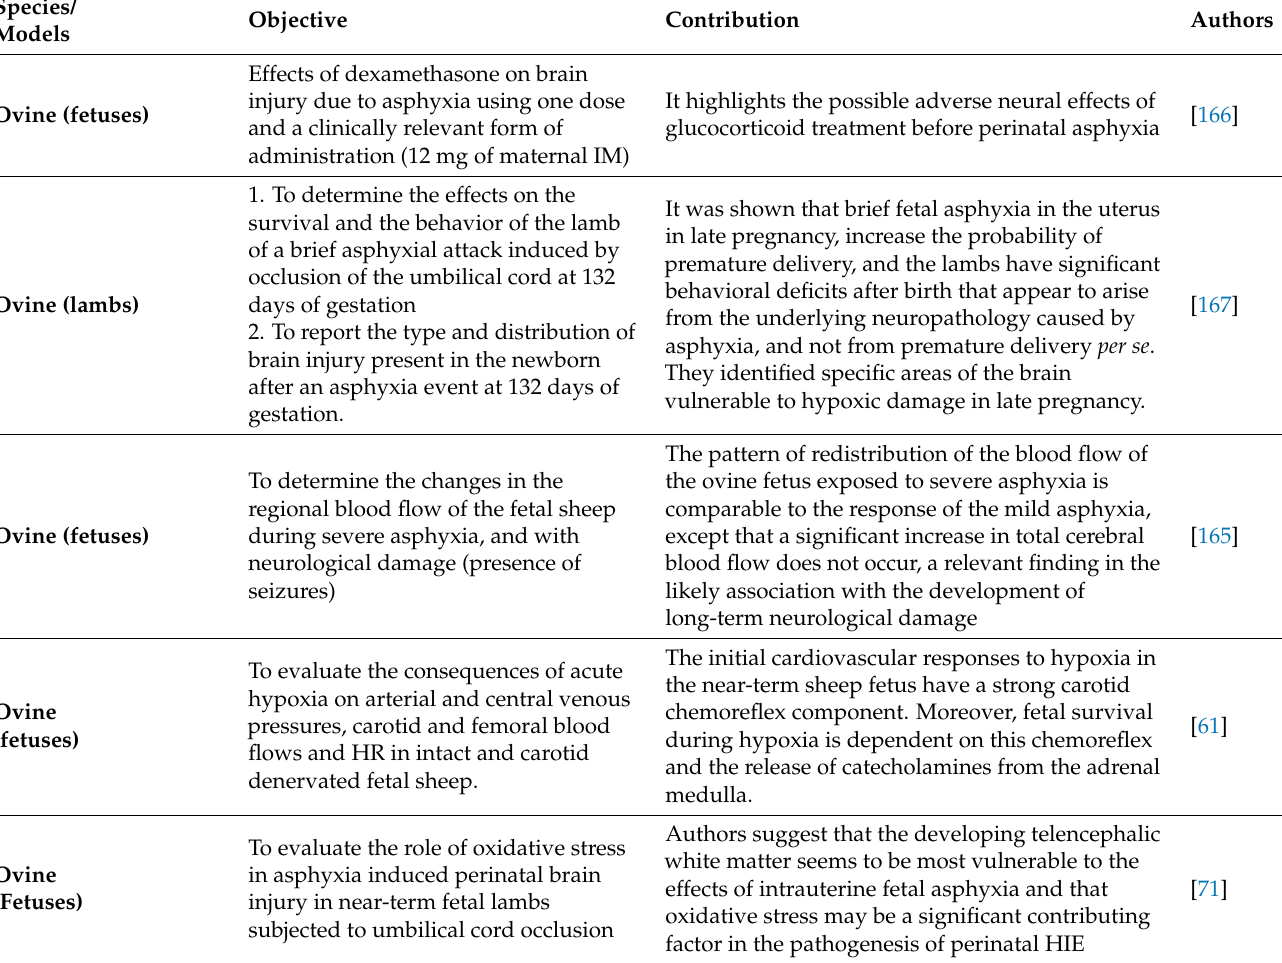
Table 1. Relevant findings of studies related to perinatal asphyxia in